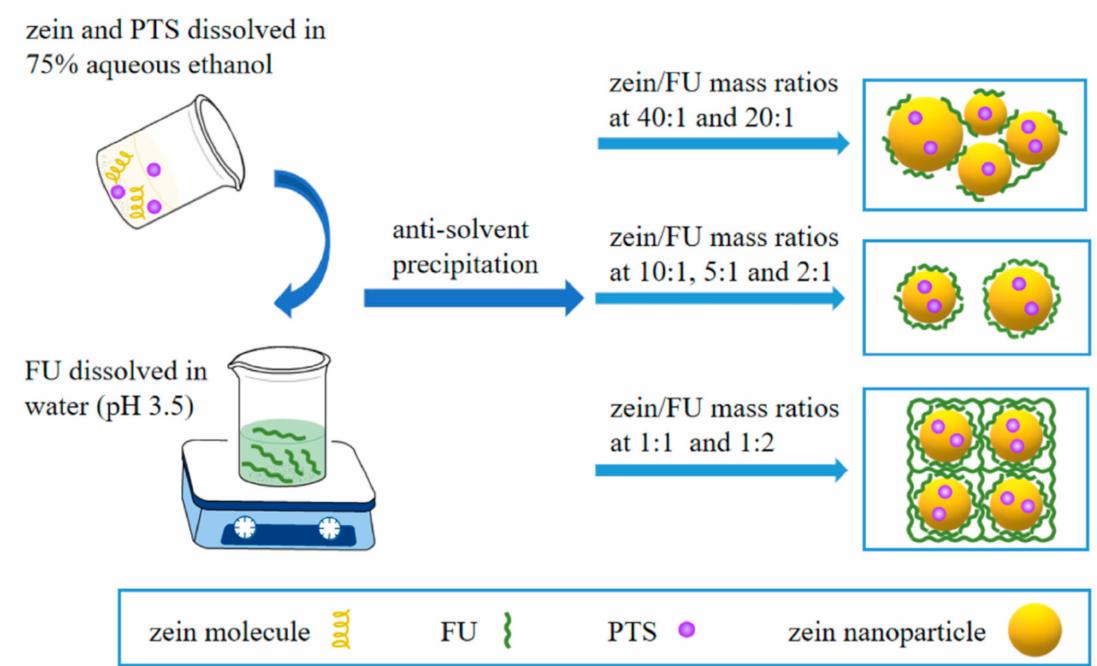
Figure 6. Schematic representation of the preparation of and possible interactions between zein, fucoidan (FU) and pterostilbene (PTS). Reprinted with permission from ref. [64]. Copyright 2020 Elsevier.